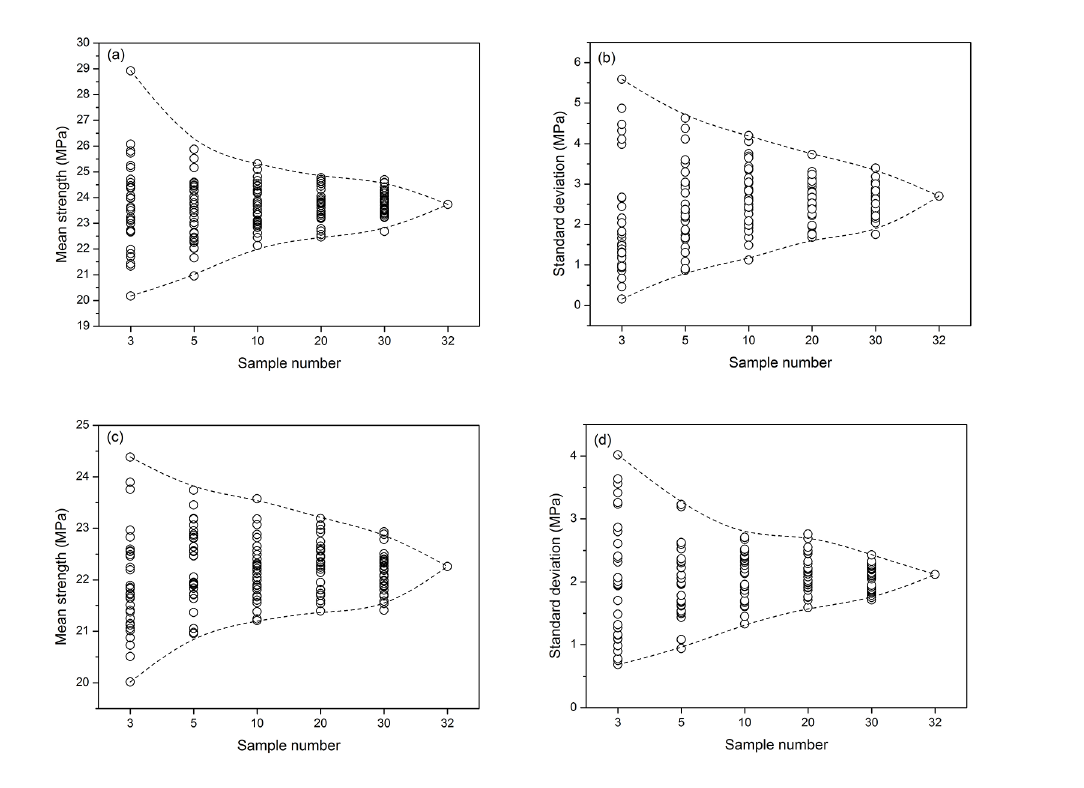
Figure 5. Mean value and standard deviation of the random selected test values of the bending strength for high alumina bricks: (a), (b) 25 mm×25 mm×150 mm and (c), (d) 40 mm×40 mm×200